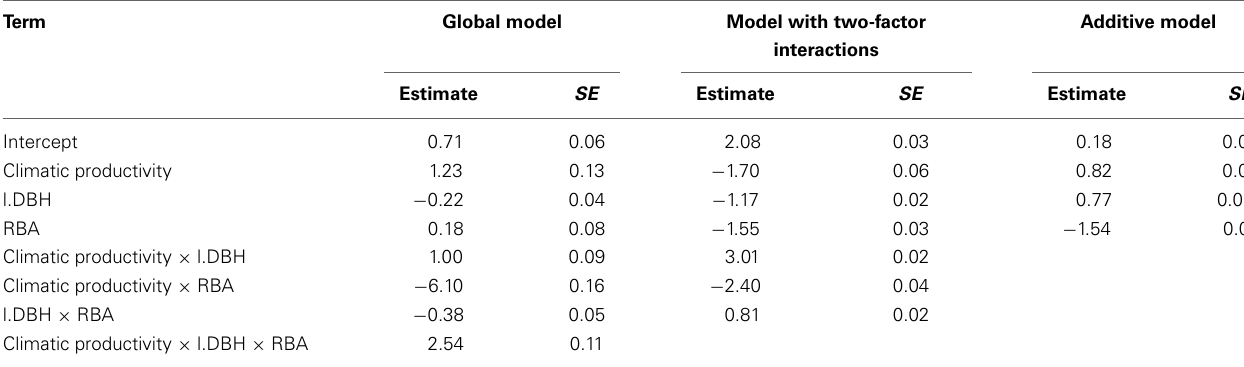
Table 5 | Coefficients and associated standard errors for the global model describing eucalypt growth in terms of climatic productivity, tree size, and competition, and their